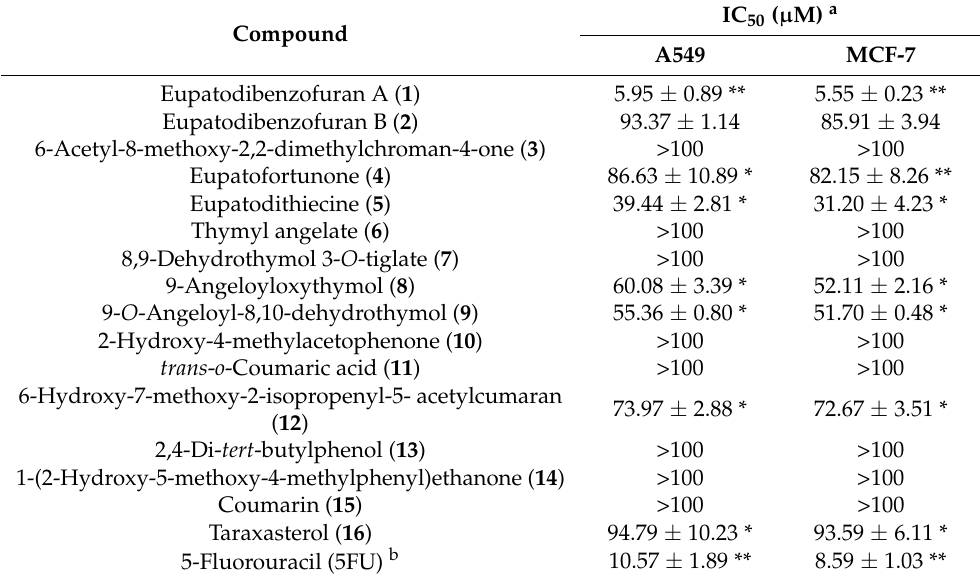
Table 5. In vitro inhibitory effects of compounds 1 - 16 isolated from the aerial part of E. fortunei against A549 and MCF-7